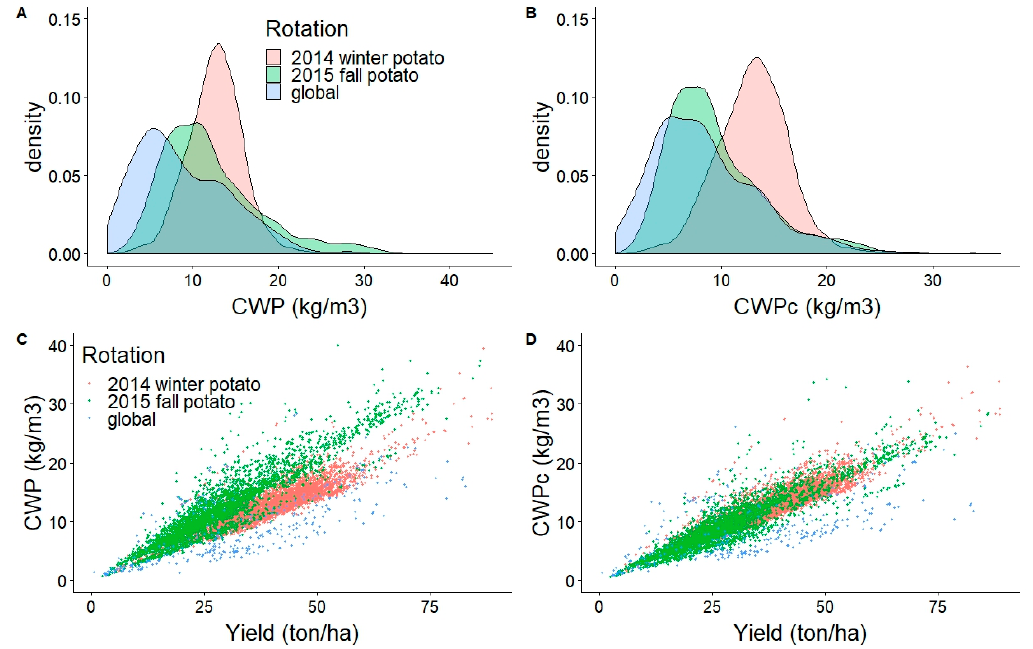
Figure 4. ( a ) Density of potato fresh tuber CWP (kg m − 3 ), ( b ) density of potato fresh tuber CWPc (kg m − 3 ), ( c ) CWP (kg m − 3 ) plotted against yield and ( d ) CWPc (kg m − 3 ) plotted against yield. Each plot shows the winter (2014 winter rotation) and the fall (2015 fall rotation) rotations in the West Bank, Palestine, as estimated in SEBAL, and global values of CWP (global) taken from literature (Appendix